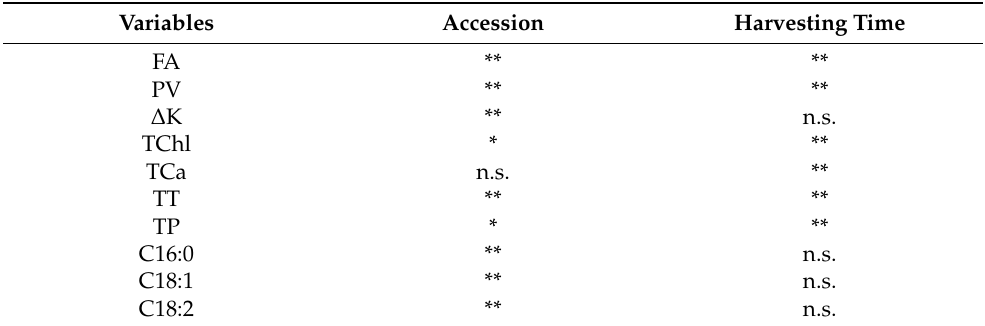
Table 4. Multivariate analyses of qualitative characteristics of olive oils extracted from drupes produced from the four minor accessions and at two harvesting